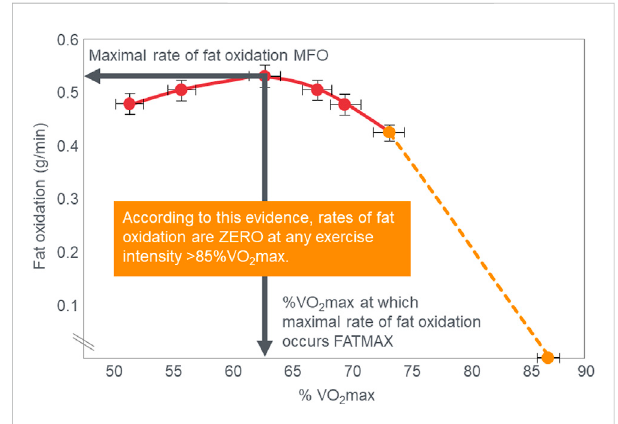
FIGURE 2 Accordingtothecrossoverconcept,ratesoffatoxidationinitially increase during exercise of low to moderate intensity reaching a maximal rate of fat oxidation (MFO) at between 60% – 65%VO 2 max (FATMAX)beforefallingsteeplyastheexerciseintensityincreases further. The model predicts that the rate of fat oxidation reaches zero at exercise intensities greater than 85%VO 2 max. Redrawn from reference (Achten and Jeukendrup,